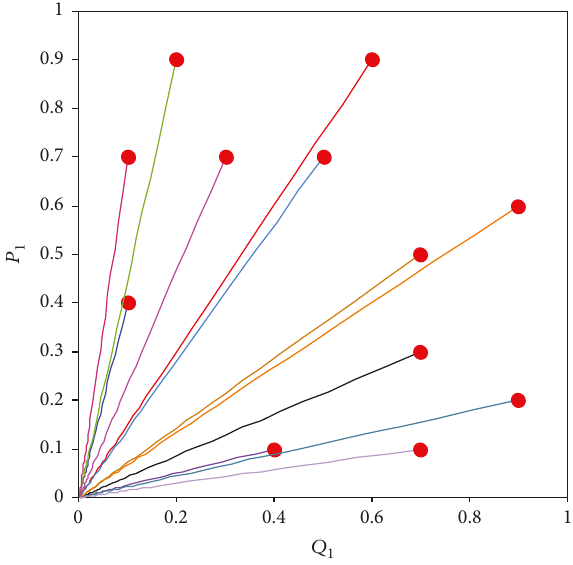
Q Figure 8: P 1 and 1 during the learning process of EAQR in Case 1 ( ε = 0 9